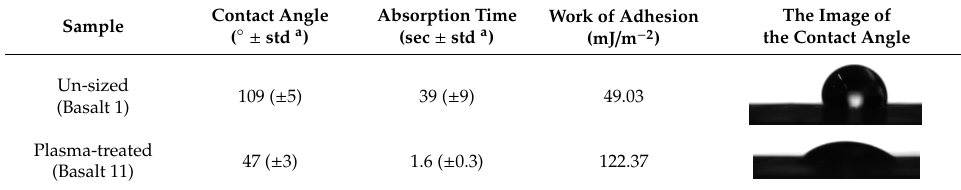
Table 5. Results of wettability assessments of un-sized and plasma-treated basalt fabric.